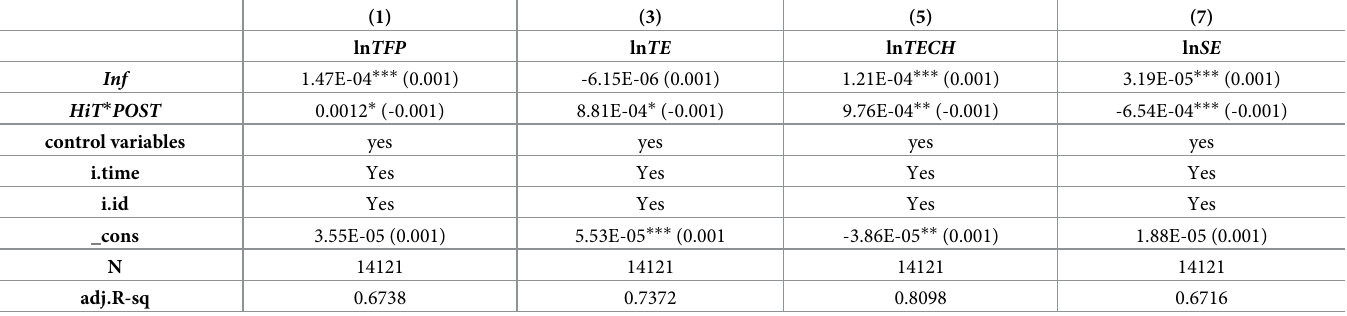
contrast, the negative effect on TE was not significant. Table 4. The direct effect of IA on enterprise